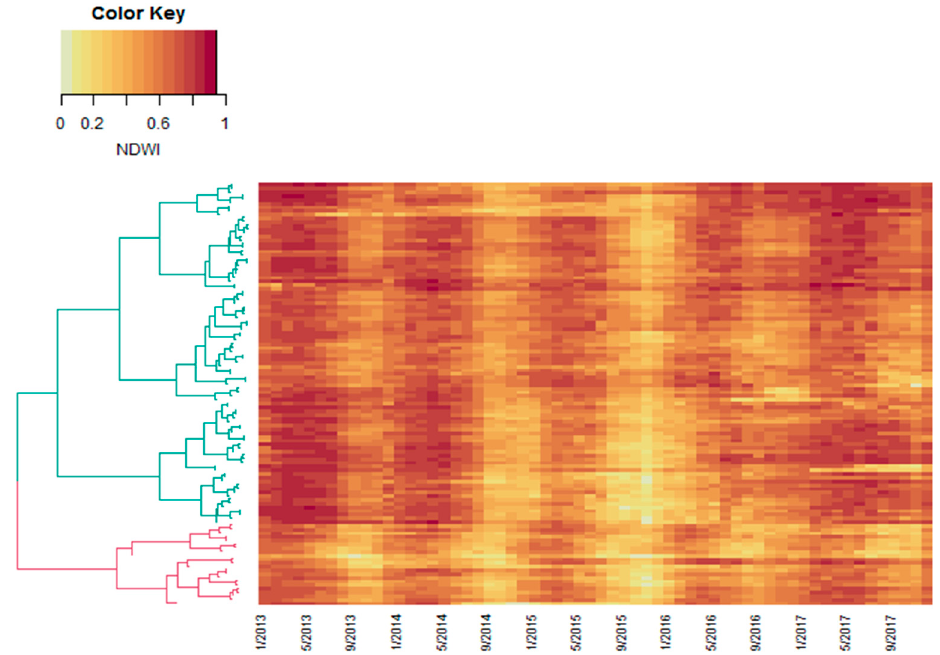
Figure 6. Figure showing the variation of NDWI values for each cluster from 2013 to 2017. Darker tones represent high NDWI values and light tones represent low NDWI values. Red in the classification tree represents drought-affected compartments and blue represents non-affected compartments.